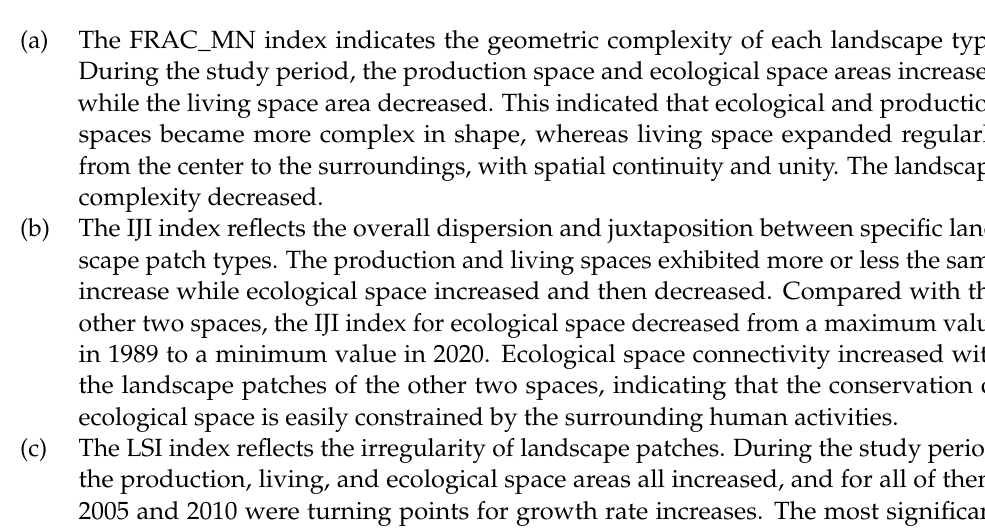
Figure 7. Landscape class dimension changes in the Poyang Lake